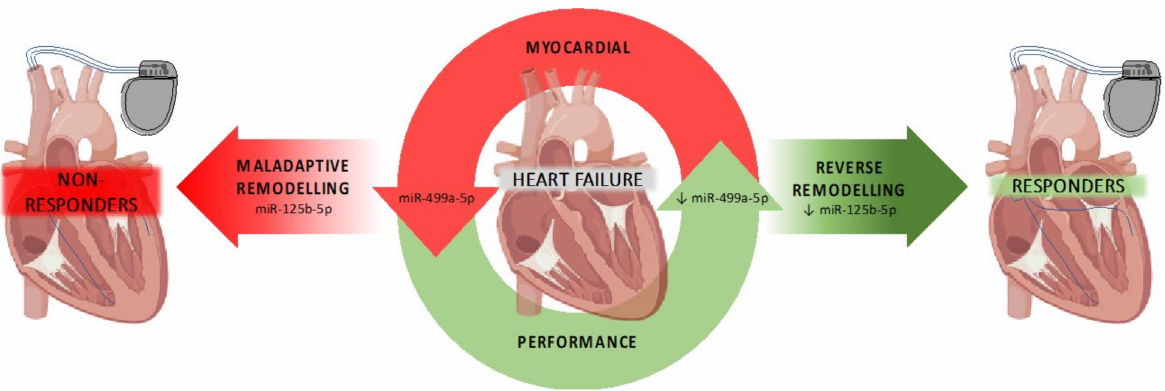
Figure 7. Graphical overview of hypothetical miRNA-regulated processes associated with CRT scheme. Supplementary Materials: The following are available online at https://www.mdpi.com/article/ Table S2: Six-month miRNAs changes in responders vs. non-responders, Table S3: Longitudinal miRNAs changes in responders, Table S4: Longitudinal miRNAs changes in a non-responders group, Table S5: AUC values of basal altered miRNA expression in responders vs. non-responders, Table S6: AUC values of longitudinal altered miRNA expression in responders, Table S7: Sensitivity and Specificity of basal altered miRNAs expression in responders vs. non-responders, Table S8: Sensitivity and Specificity of longitudinal altered miRNAs expression in responders, Table S9: Basal Real-time RT-PCR cycle threshold (Ct) values of 84 cardio-miRs in responder patients, Table S10: Longitudinal Real-time RT-PCR cycle threshold (Ct) values of 84 cardio-miRs in responder patients, Table S11: Basal Real-time RT-PCR cycle threshold (Ct) values of 84 cardio-miRs in non-responder patients, Table S12: Longitudinal Real-time RT-PCR cycle threshold (Ct) values of 84 cardio-miRs in non-responder